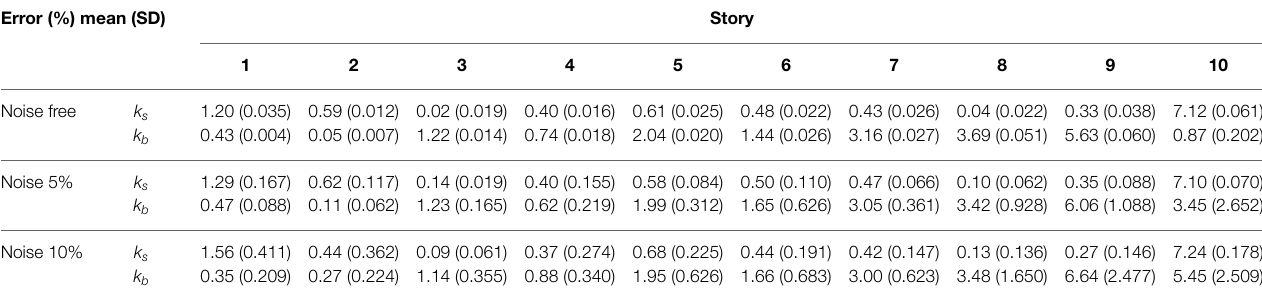
TABLE 2 | Mean and SD of error ratio of identified stiffnesses in simultaneous measurement (10 times investigation using different micro-tremors). Error (%) mean (SD)